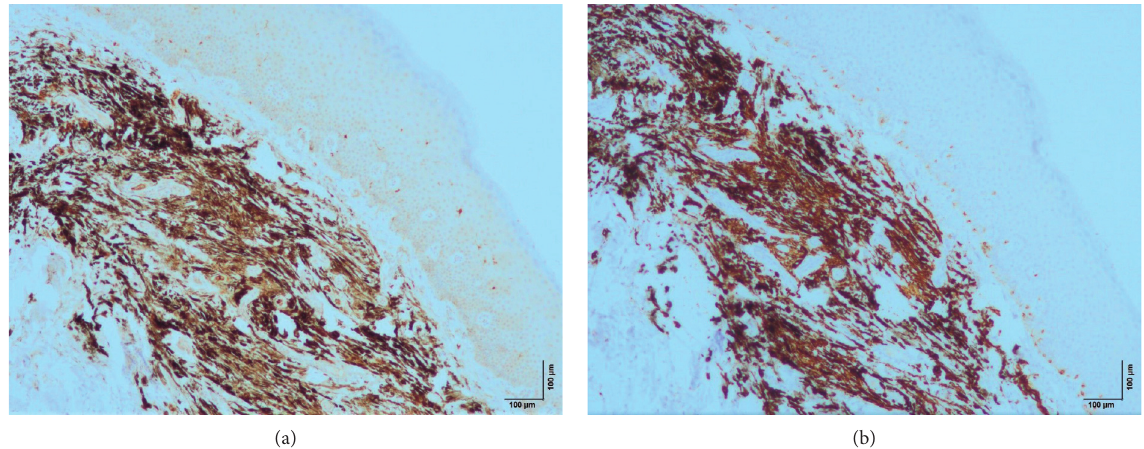
Figure 3: Microscopic examination at magnification 100x. Nevus cells stain for MelanA (a) and S100 (b).